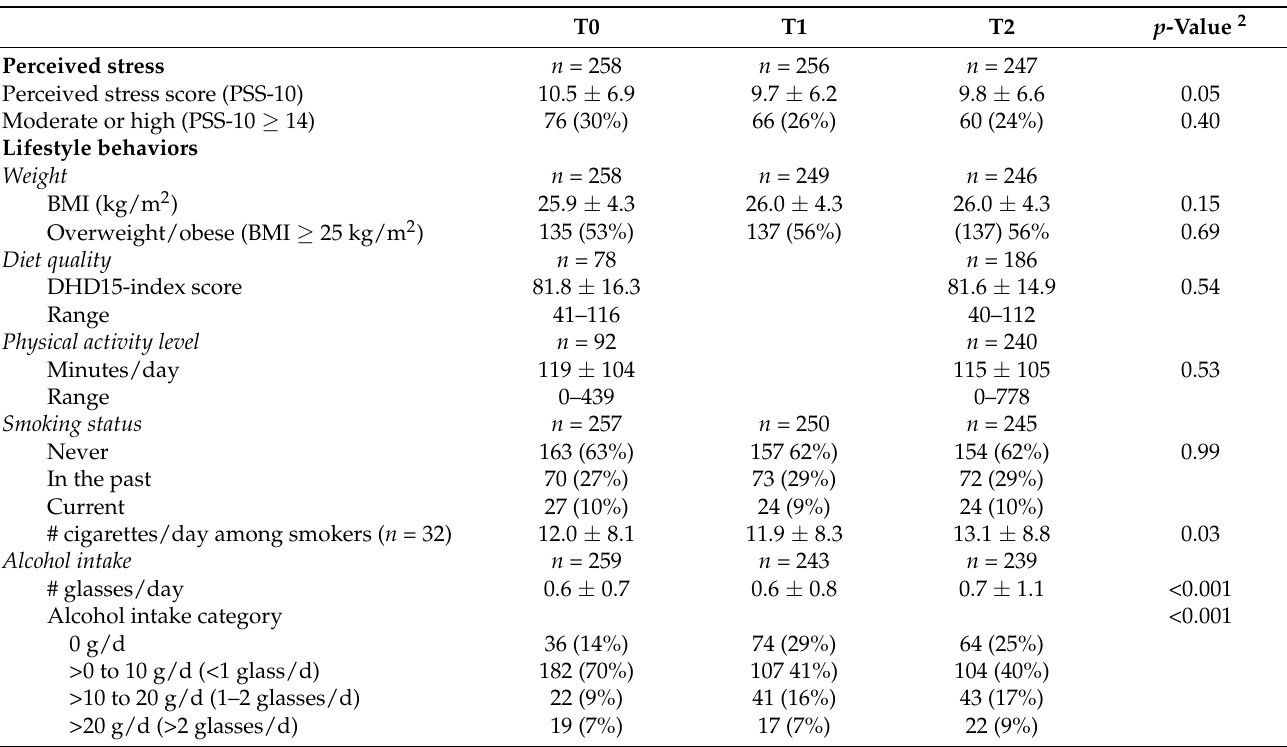
Table 3. Perceived stress and lifestyle behaviors of the study sample ( n = 259) according to